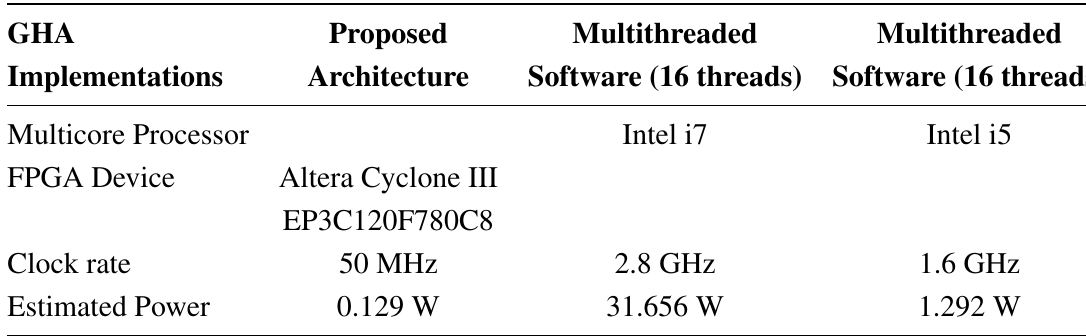
Table 4. Power Consumption of Various GHA